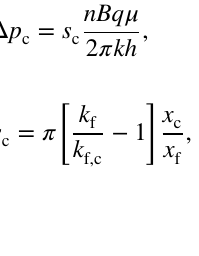
Fig. 3 Asphaltene deposition and fracture choking